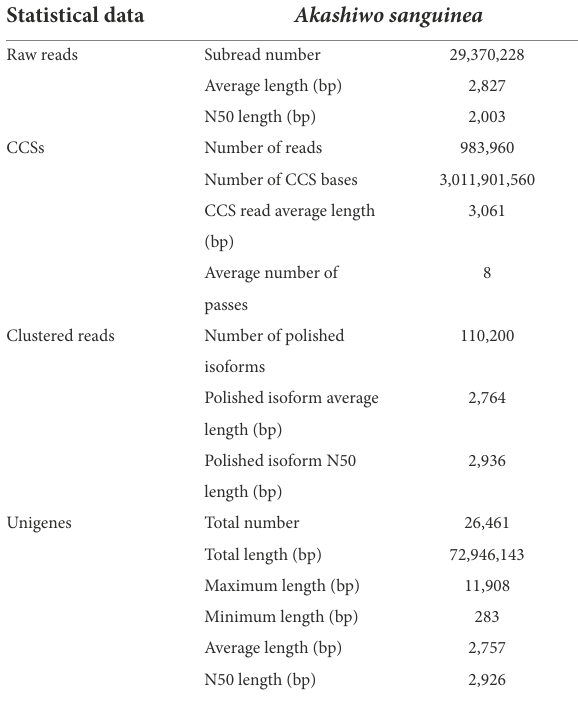
FIGURE 1 Overall experimental workflow and transcriptome bioinformatics analysis pipeline in this study.